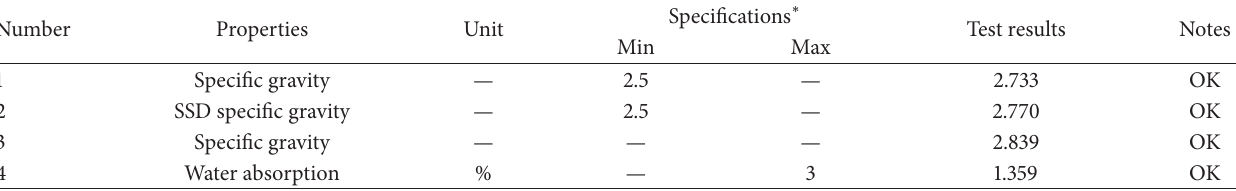
Table 6: Properties of fine aggregates.